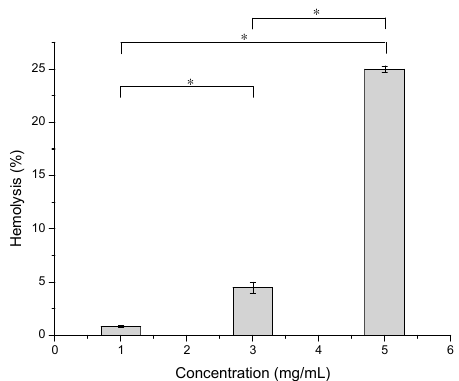
Figure 7. In vitro hemolysis after incubation with SA-BSPs copolymer micelles (* p < 0.05).